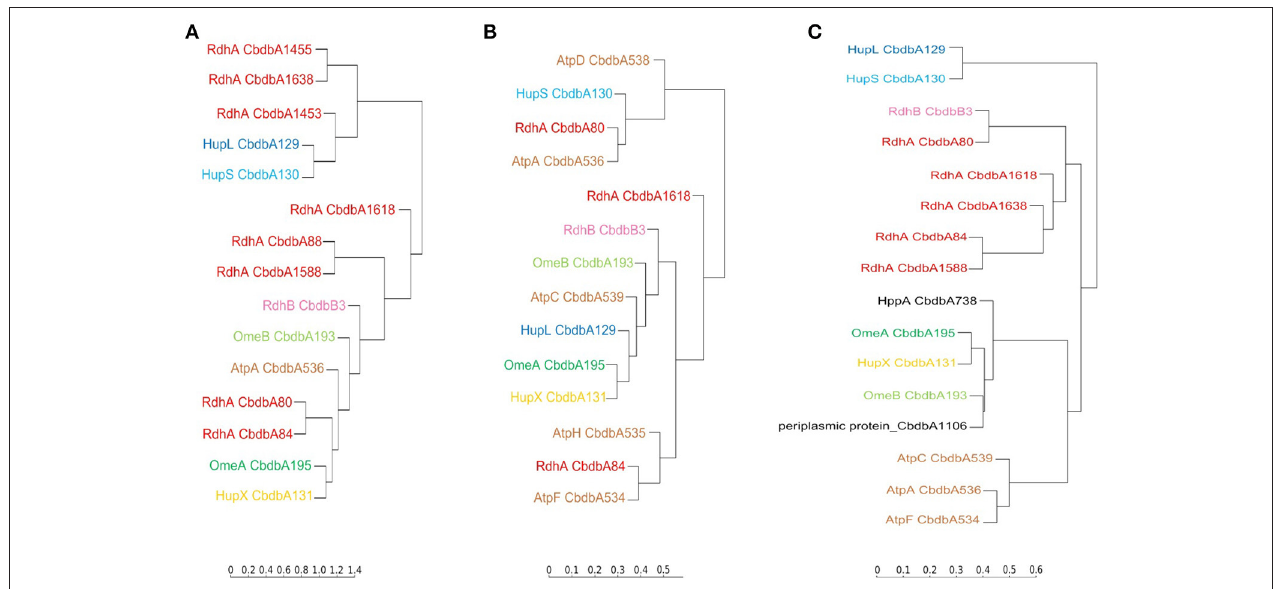
FIGURE 6 | Cluster analysis of the distribution profiles of proteins suspected to be part of the OHR complex across blue native gels after application of the three extraction modes. (A) Distribution on blue native gels after extraction mode 1; (B) after extraction mode 2; (C) after extraction mode 3. The cluster analysis places proteins with similar migration pattern together. Colors are used as elsewhere in this study. ATP synthase subunits (brown) are added as reference. Two other proteins having a similar distribution of relative protein abundance across the gel in extraction mode 3 as the OmeA/OmeB/HupX module are displayed in black. The full analyses are given in Supplemental Figure 3